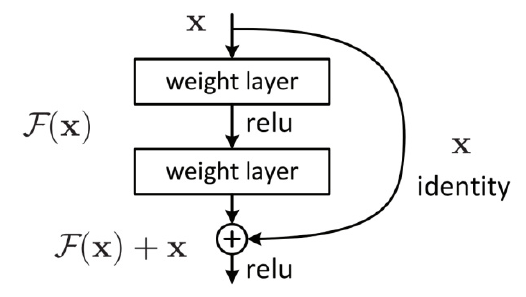
Figure 1. Residual block.